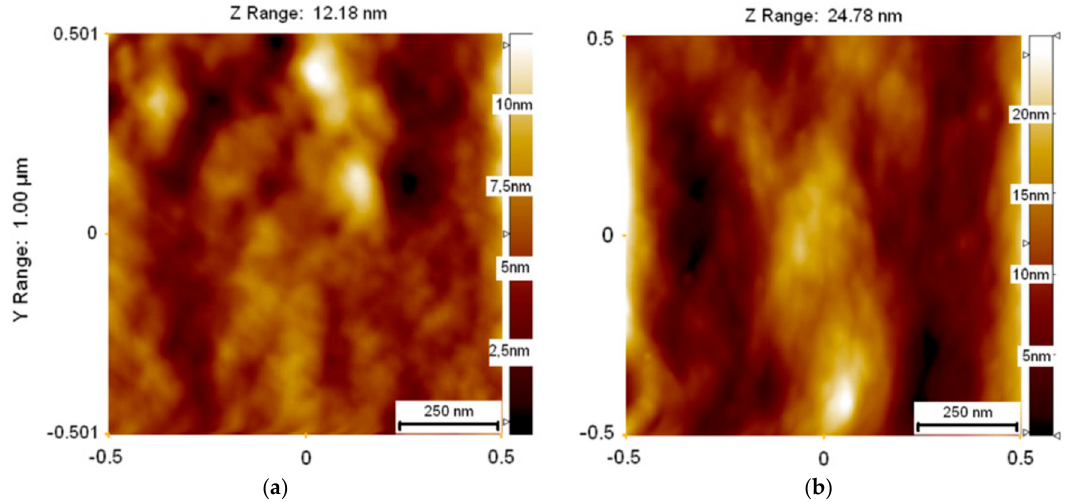
Figure 2. Atomic force microscopy images of the blends prepared using the solvents oDCB ( a ) and oDCB+THN ( b ).